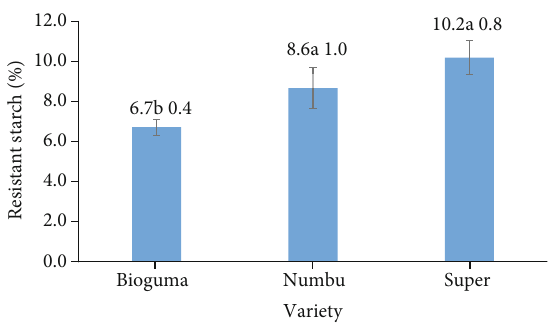
Figure 11: Fat content of three varieties of polished sorghum